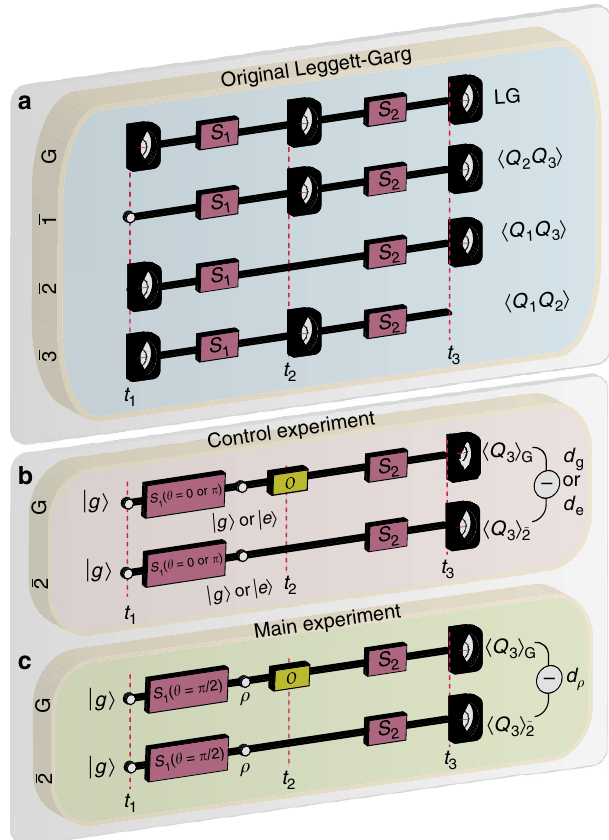
Figure 1 | A simplified test of macrorealism. ( a ) Leggett–Garg (LG) derive their inequality-constraint on macrorealism by considering a measurement of a bivalent observable Q at three consecutive times (on an ensemble ‘G’ of two-level systems). The inequality is tested by gathering two-time correlators from separate experiments, each with a measurement omitted at one of the instants (ensemble ‘ (cid:2) 1’ and so on). The lower pane shows our full, simplified experimental protocol. In our experiment the shuffling operations are pulses induced with resonant microwave radiation